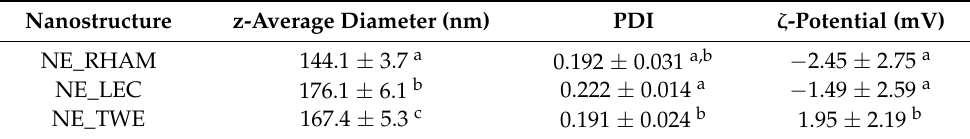
Table 1. Particle size, polydispersity index (PDI), and ζ -potential of curcumin-loaded nanoemul- sions (NEs) produced with different emulsifiers (rhamnolipids (RHAM), lecithin (LEC), and tween 80